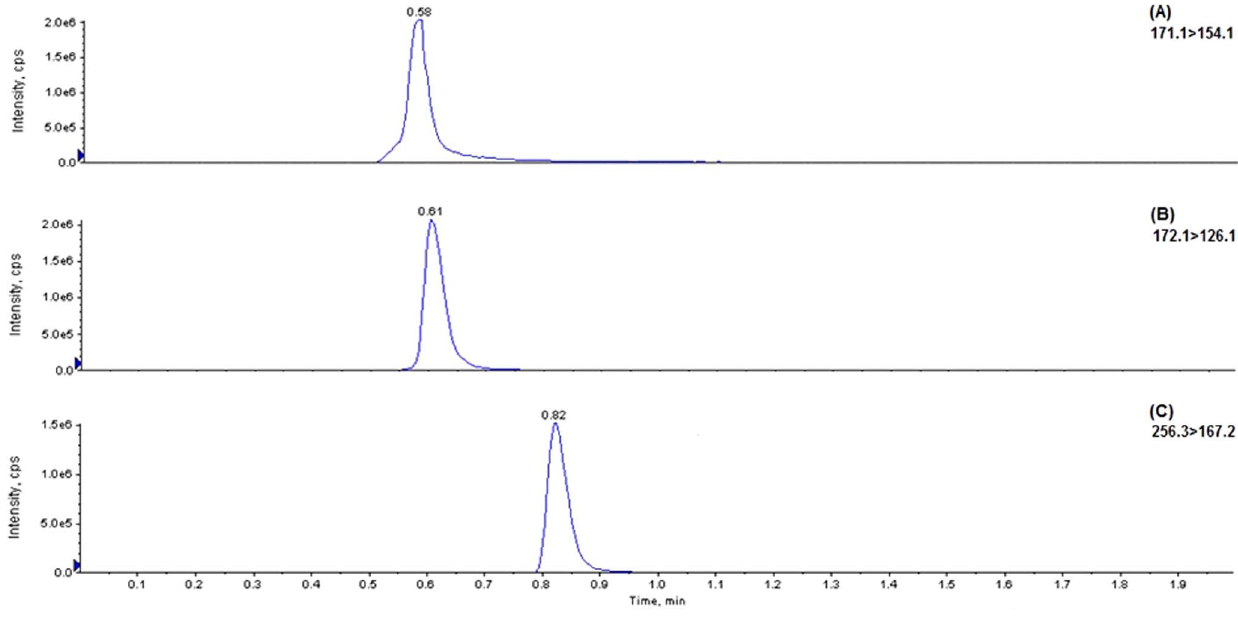
Figure 2. Chromatograms of extracted plasma spiked with (A) LEV at 50 m g/mL [QC medium level], (B) UCB L057 at 50 m g/mL [QC medium level] and (C) IS.